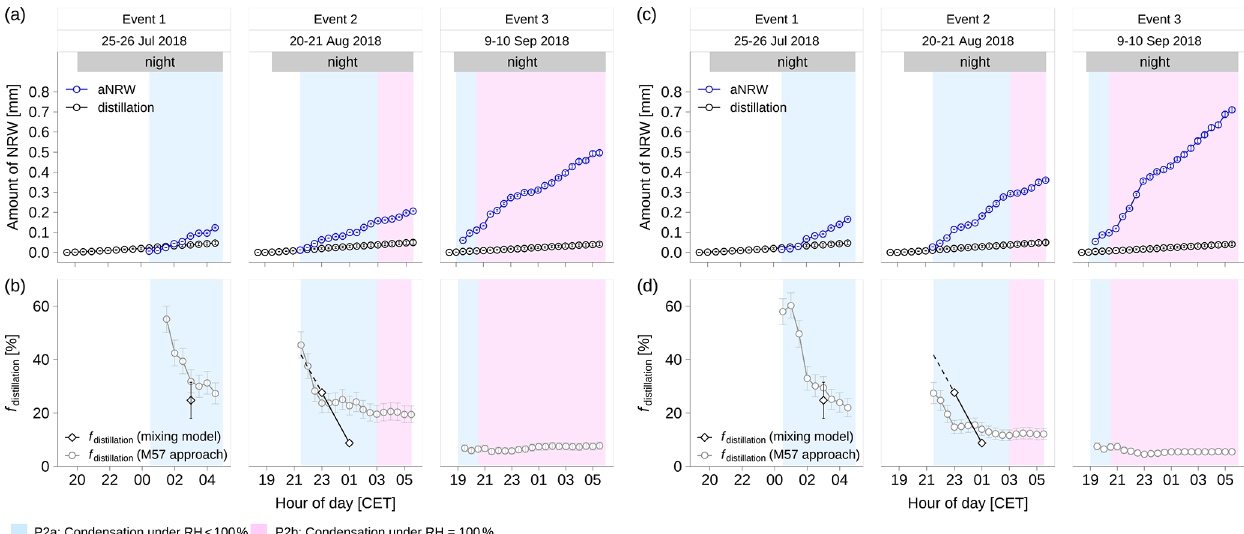
Figure E1. The non-rainfall water amount and distillation contribution given different semi-empirical forms of stability parameter (cid:56) . Panels (a) and (b) show the results given (cid:56) = 1 /( 1 + 10 · Ri) following Monteith (1957). Panels (c) and (d) show the results given (cid:56) = [ 1 − 16 · (z − z d )/ L ] − 0 . 5 = [ 1 − 16 · Ri ] − 0 . 5 for Ri< − 0 . 1 and (cid:56) = [ 1 + 5 · (z − z d )/ L ] = [ 1 − 5 · Ri ] − 1 for − 0 . 1 ≤ Ri ≤ 1 following Monteith and Unsworth (2013). The P2a period was dew formation period in the conditions of relative humidity <100%; the P2b period was the combined dew and radiation fog period in the conditions of relative humidity =